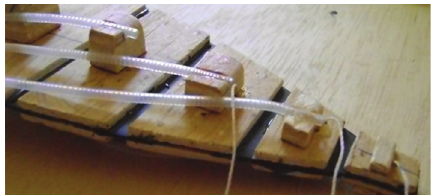
Figure 12: The assembled tail (joint) showing the polythene pipe through which the cables are treaded. The ends of the pipes are glued to the quarter pulley. The plywoods (1/8in/3.175 mm) are glued to the rubber stripes to form the tail joints. The cables are connected to the next wooden support.